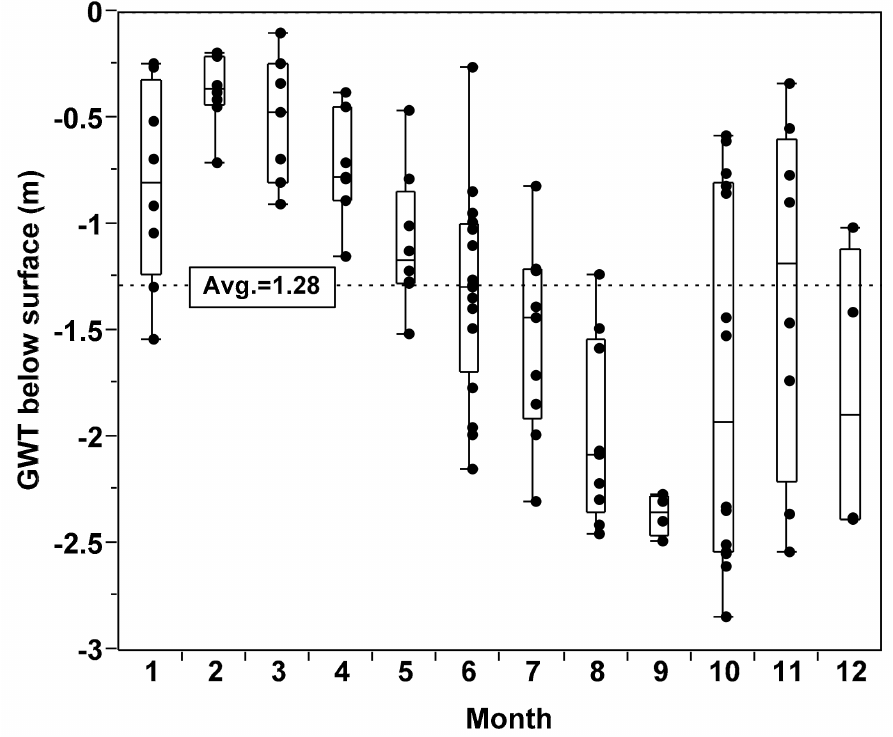
Figure 6. Average and monthly levels of groundwater table between October 1994 and June 2010 at Roxobel, NC, as monitored by the USGS (USGS Sta. 361420077111407